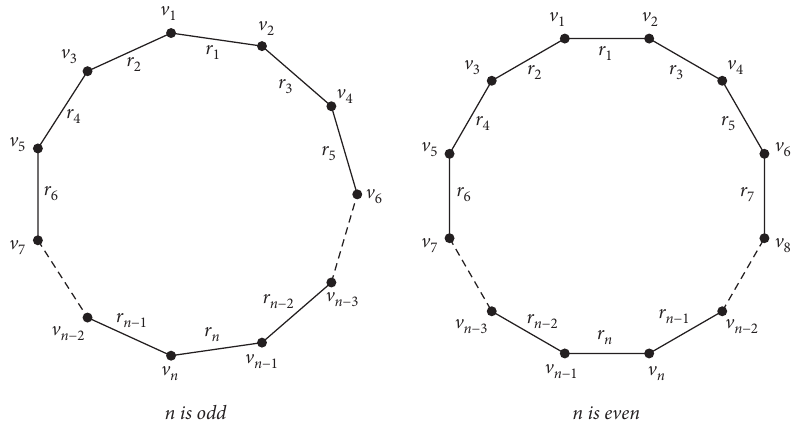
Figure 3: Edge labeling of C